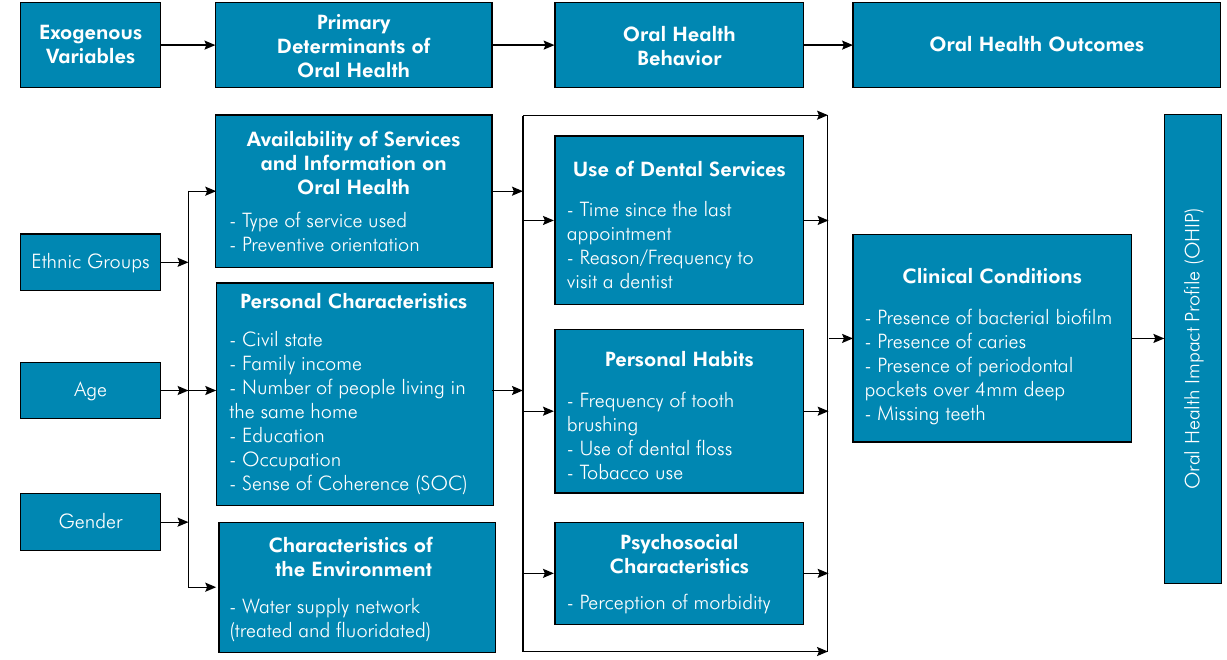
Figure. Adapted conceptual framework for the Oral Health Impact Profile outcome.